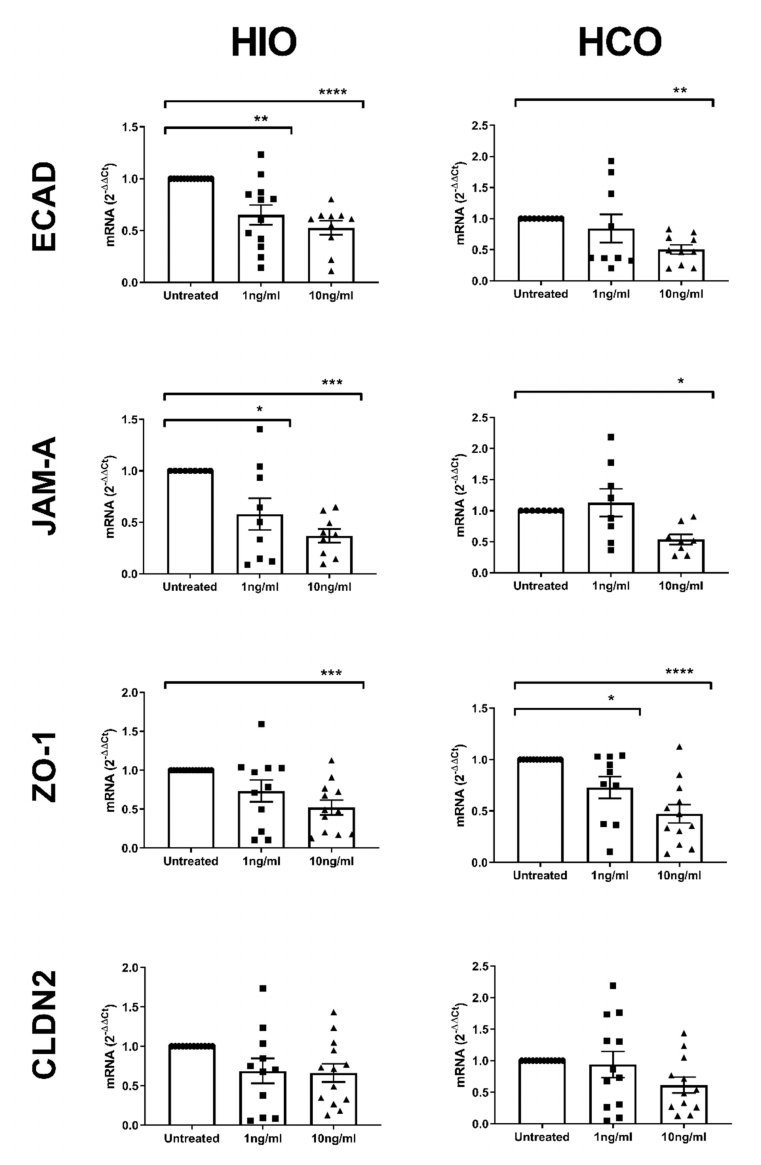
Figure 5. E ff ect of TNF α and IFN γ (1 and 10 ng / mL) for 72 h on the gene expression of ECAD , JAM-A , ZO1 and CLDN2 as measured by qRT-PCR. Relative gene expression is expressed as the ∆∆ C t of GAPDH expression of controls. Two-way ANOVA with Bonferroni’s multiple comparisons; * p < 0.05, ** p < 0.01, *** p < 0.001, **** p < 0.0001 compared with respective control. Each value represents the mean ± SEM, n = 3, with 3 independent